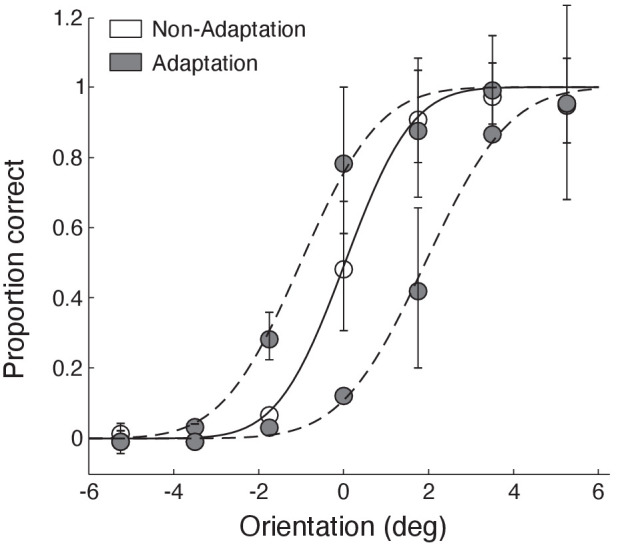
Behavioural tilt-aftereffect.We investigated whether the layer-specific fMRI adaptation we observed relates to perceptual bias in orientation discrimination due to adaptation. We tested a subset of participants that took part in the fMRI study (N = 12) in an additional behavioural session using a tilt-aftereffect paradigm (e.g. Gibson and Radner, 1937). We presented participants with the same stimuli (oriented gratings) as in the fMRI experiment in adaptation vs. non-adaptation blocks. Participants were asked to perform the same RSVP task as in the fMRI experiment. Each block was followed by a test stimulus (a single grating with orientation close to vertical). Participants were then asked to judge whether the test stimulus was tilted clockwise or counterclockwise relative to vertical. We fitted psychometric functions to the participant responses (N = 12). Open circles indicate non-adaptation data, grey circles indicate adaptation for clockwise and counter-clockwise orientations from vertical. Solid line indicates fitting of the non-adaptation condition data, dashed lines of the adaptation condition data. Participant responses showed a perceptual bias, that is, a significant shift in the perceived orientation of the test stimulus for adaptation compared to non-adaptation (t(11)=3.197, p=0.0085).